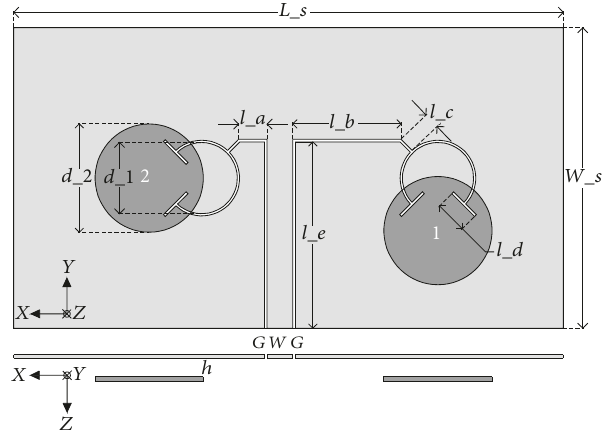
Figure 1: The geometry of the 1 × 2 linear antenna array.